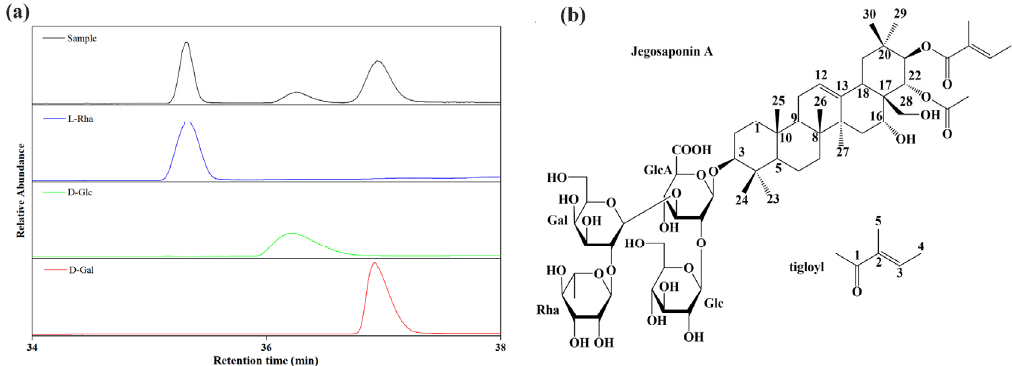
Figure 3. GC-MS chromatograms of sugar groups ( a ) and molecular structure of jegosaponin A ( b ). L-Rha: L-rhamnose, D-Glc: D-glucose, D-Gal: D-galactose. Table 1. 1 H (700 MHz) and 13 C (176 MHz) NMR spectroscopic data for compound 1 in pyridine-d5.